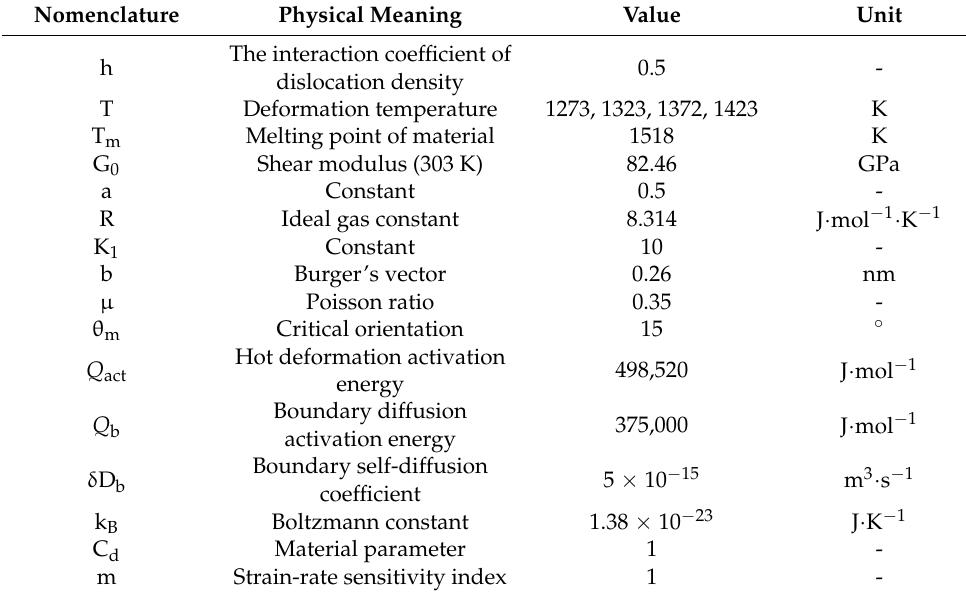
Table 2. Materials parameters of the studied alloy steel for CA